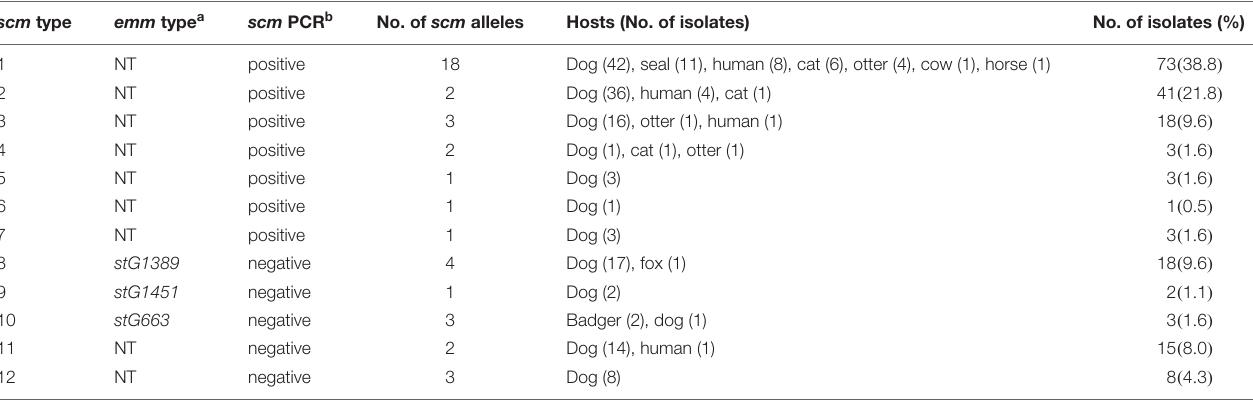
TABLE 1 | Characteristics of the 188 S. canis